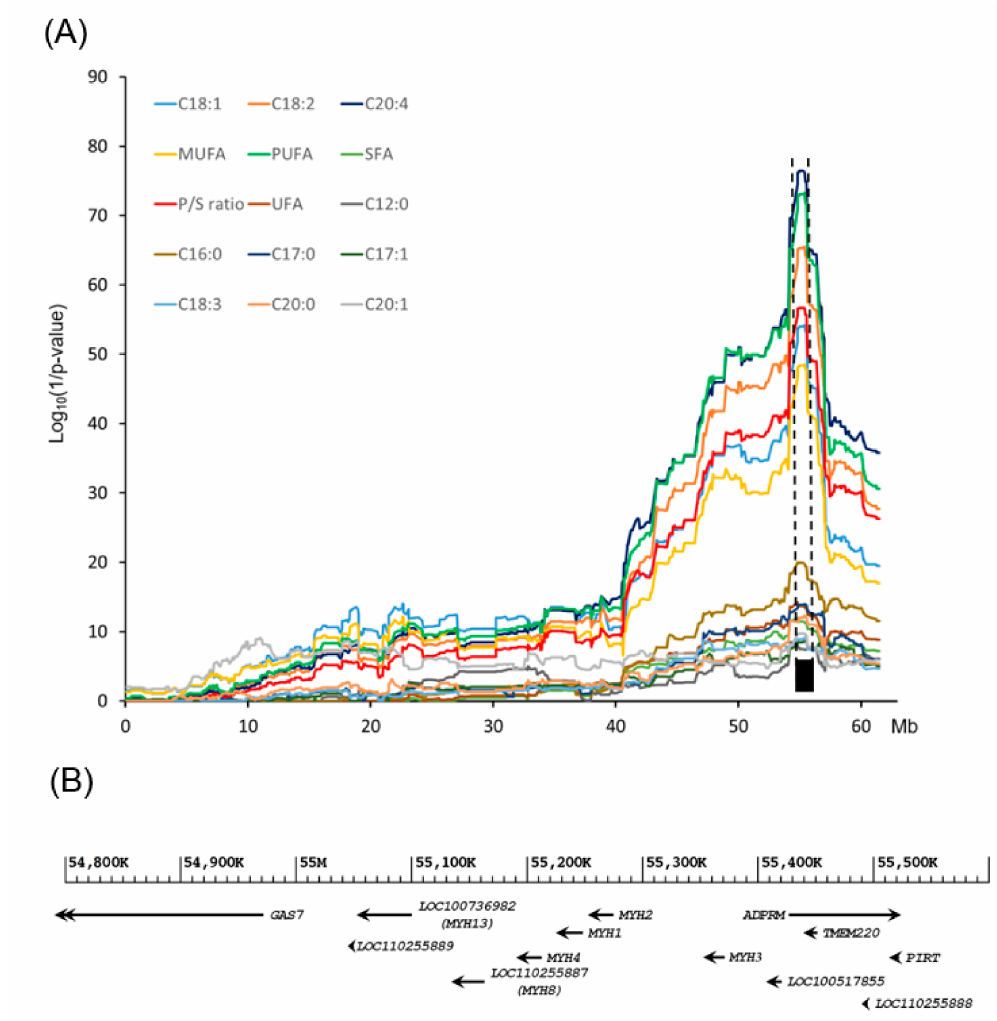
Figure 2. Post-GWAS high-resolution mapping of a QTL that influences FA composition traits of the longissimus dorsi muscle of the LK cross. ( A ) LALD mapping results in SSC12 for FA traits. The y-axis shows the log 10 (1/ p -value), and the x-axis shows the genomic map positions of the SNP markers in SSC12. The width of the black rectangle represents 1-LOD drop confidence interval corresponding to the 749.1 kb region in SSC12 (12: 12:54,812,172-55,561,243). ( B ) Ten NCBI protein-coding genes are located within the 749.1 kb region associated with the FA composition traits. Gene names in parentheses were annotated by our previous study